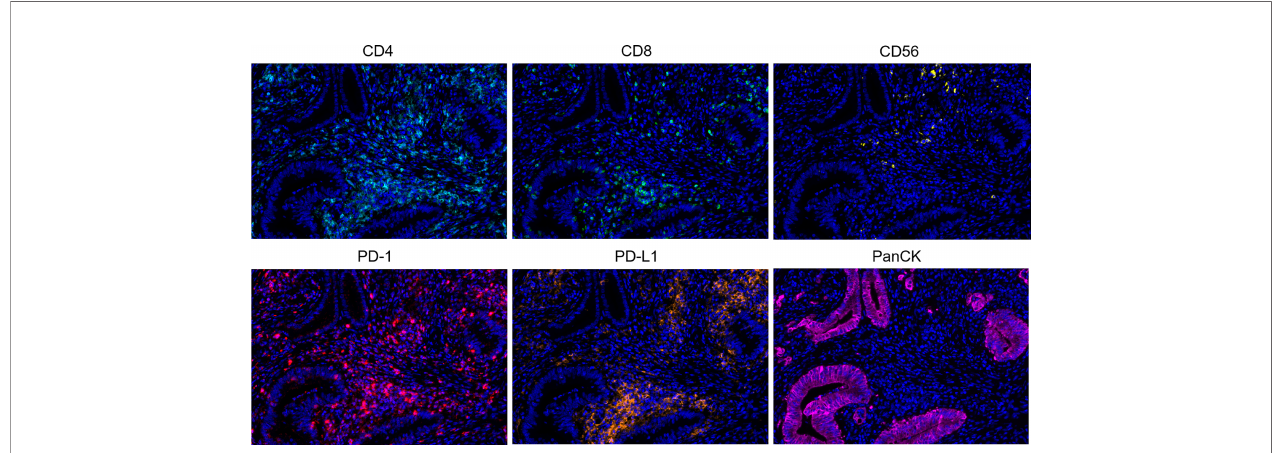
FIGURE 1 | Representative multiplex immuno fl uorescence images of positive staining in colorectal cancer tissue sections. Color scheme - Cyan: CD4, Green: CD8, Yellow: CD56, Red: PD-1, Orange: PD-L1, Magenta: PanCK, Blue: DAPI.